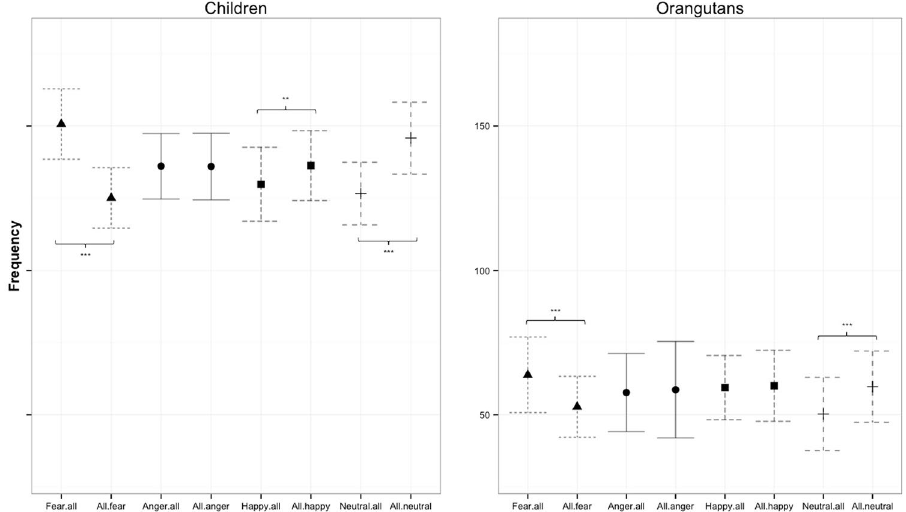
Figure 2. Fixation rates at human facial expressions: Mean estimates of the fixation rates at the target emotion (either Fear, Anger, Happy or Neutral) compared to all corresponding distractors (e.g. “Fear.all” = fear compared to happy, anger, neutral) for human children and orangutans. The corresponding combinations (e.g., Fear.all and All.fear) are depicted by the same symbols and lines. Significant comparisons are indicated by asterisks ( > 0.01 * ; > 0.05 ** ; > 0.01 *** ). Note that scales are identical for both plots.